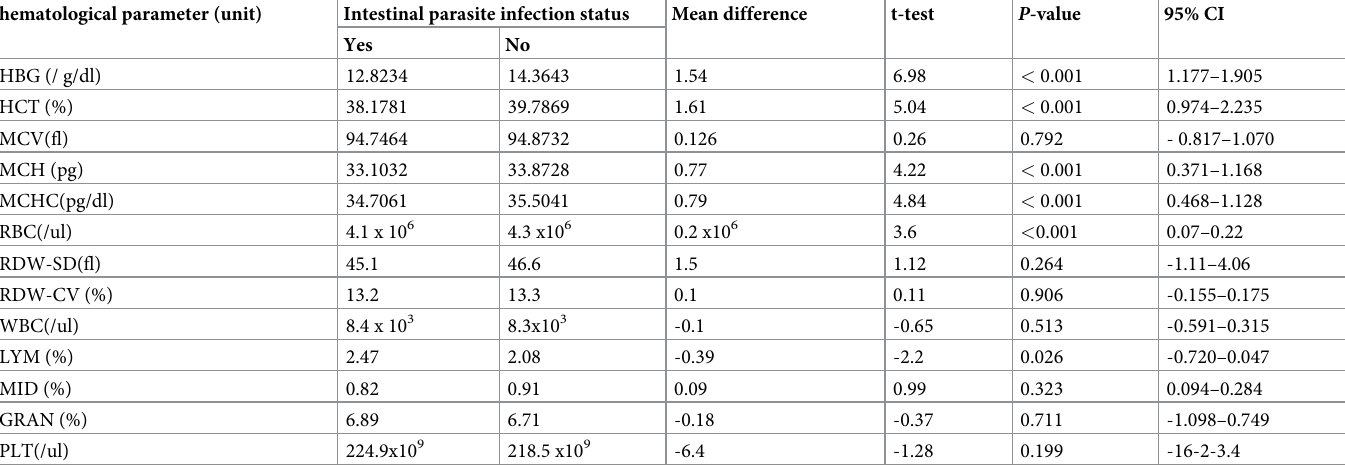
Table 4. The mean hematological profile value difference between intestinal parasite-infected and intestinal parasite-free pregnant women at Debre Markos Refer- ral Hospital, Ethiopia. hematological parameter